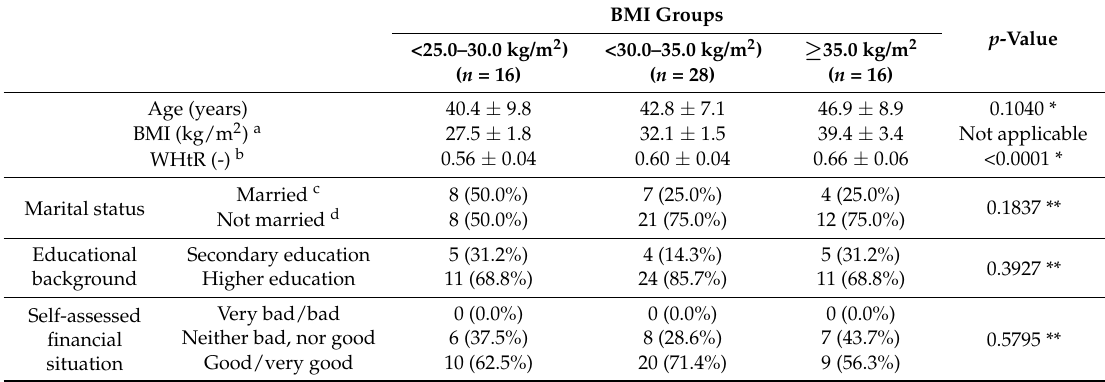
Table 2. The characteristics of the studied group for the sub-groups stratified by